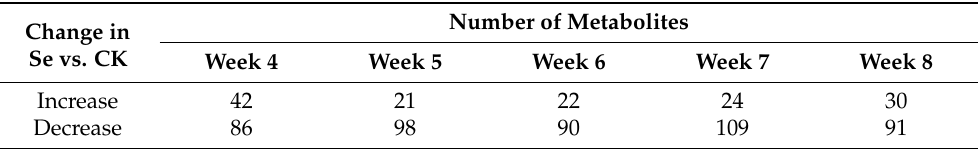
Table 5. Changes in metabolite profiles in the mycelia of Epichloë sinensis between Se and control groups during weeks